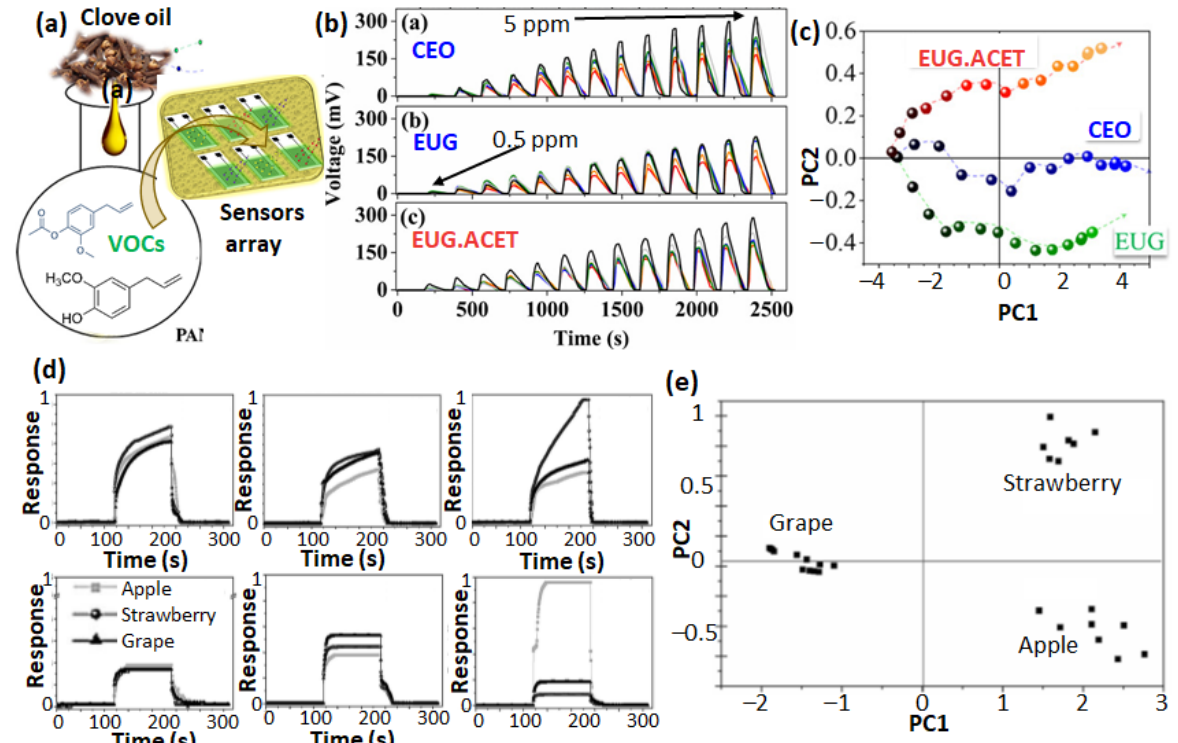
Figure 9. Representation of VOC biomarkers for clove oil detection by a CPC sensor-based array ( a ). The responses of the six sensors (indicated in different colors) towards three different VOC aromas in the concentration range from 0.5 to 5 ppm ( b ). PCA analysis of the e-nose signal towards three different VOCs ( c ). Adapted from ref. [118]. Individual response of the 6 poly(aniline)-based CPC sensors towards the aroma of apple, strawberry, and grape ( d ) and the corresponding score plot obtained after PCA analysis on the sensor response ( e ). Adapted from ref. [119].